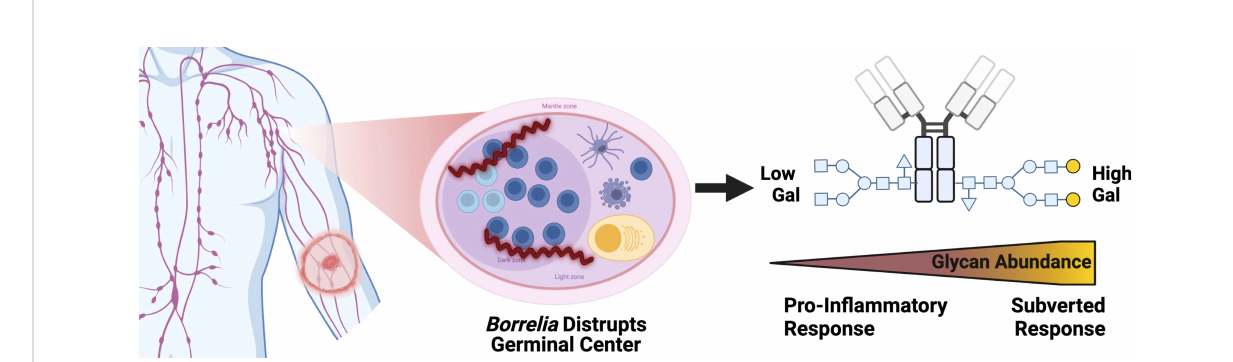
FIGURE 5 IgG N-glycans Respond to acute Lyme disease infection with increased galactose, impairing bound IgG to signal for in fl ammation, unlike other pro-in fl ammatory disease IgG signatures. Left to right, a tick infected with Borrelia transmits the infection to the human host leading to LD. The Bb spirochete disrupts the architecture of the germinal center within the lymph node. IgG molecules produced. Created with